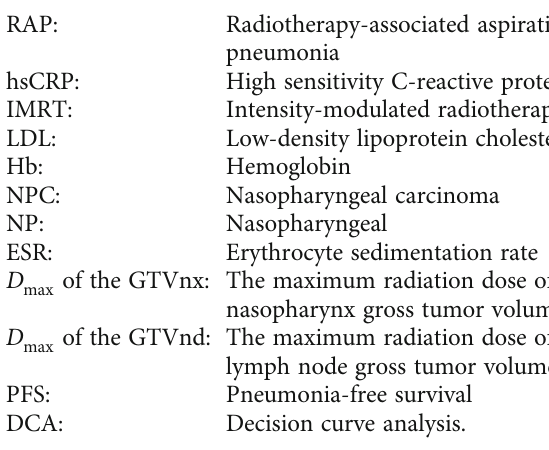
Supplementary 1 . Supplementary Figure 1: fl owchart. This fi gure showed the screening process. Supplementary 2 . Supplementary Figure 2: the